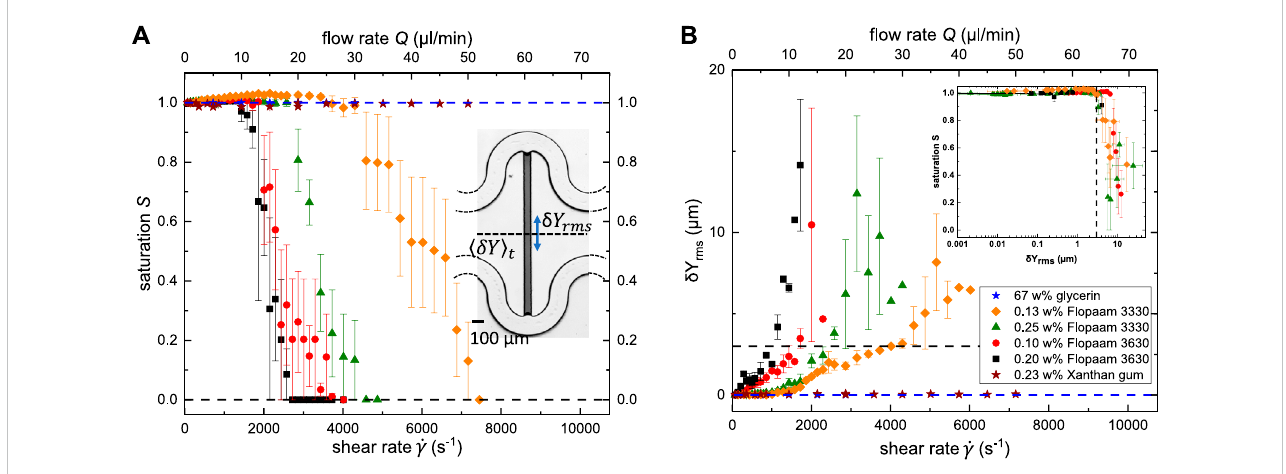
FIGURE 7 (A) Remaining oil saturation S in the side channel, and (B) root-mean-square (rms) of δ Y fl ow rate (top) and corresponding rms as function of the applied shear rate (bottom). The insets display an optical image of micro fl uidic geometry in (A) , and the remaining oil saturation S as a function of δ Y rms in (B) . The dashed line in (B) indicates the strength of fl uctuation of δ Y rms ≈ 3 μ m required to trigger the mobilization of the entrapped oil. The symbols in (A) and (B) represent experimental data for 67 w% glycerin (blue star), 0.13 w% Flopaam 3330 (orange diamond), 0.25 w% Flopaam 3330 (green triangle), 0.10